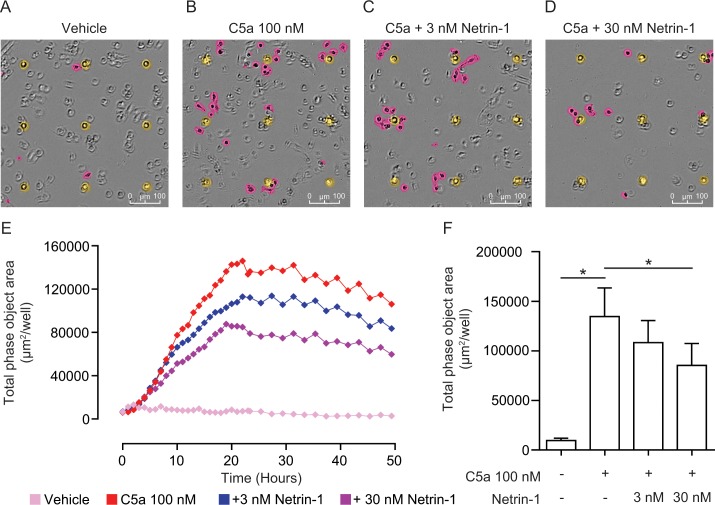
Confirmation of the inhibitory effects of netrin-1 on macrophage chemotaxis using a real-time microscopy based migration assay.BMDMs were incubated with either vehicle, 3 nM or 30 nM netrin-1 for 45 min at 37°C, 5% CO2 prior to being placed into the upper chamber of an IncuCyte® ClearView chemotaxis plate (5000 cells/well), which had been coated with Matrigel (50 μg/ml for 30 min at 37°C and 30 min at RT). Cells were then allowed to migrate towards vehicle or 100 nM C5a and chemotaxis was measured by imaging the underside of the well every 2 hours and calculating total underside cell area. Representative images of cells migrating towards (A) vehicle or (B) 100 nM C5a and cells migrating towards 100 nM C5a that had been treated with (C) 3 nM or (D) 30 nM netrin-1. The pores connecting the upper and lower chambers are masked in yellow and cells that have migrated to the underside of the well are masked in pink. (E) A representative real-time trace of total cell area on the underside of the well against time. (F) Quantification of BMDM chemotaxis by maximum cell area reached on the underside of the well. Data are mean + SEM, n = 4 biological replicates with 4 technical replicates per condition. Statistical analysis was conducted by one-way ANOVA with Dunnett’s multiple comparisons correction.* P < 0.05 for indicated comparisons.